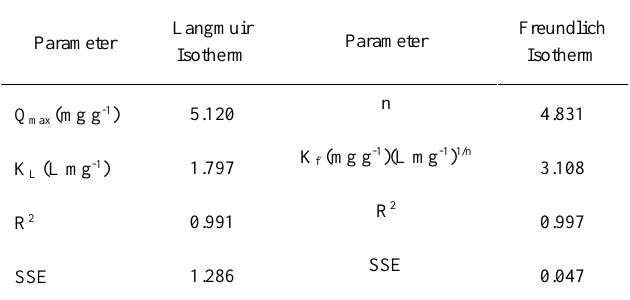
Fig. 4. Plotting result of adsorption isotherm of MB adsorption onto Table 2. The Isotherms Parameter and its Coefficients